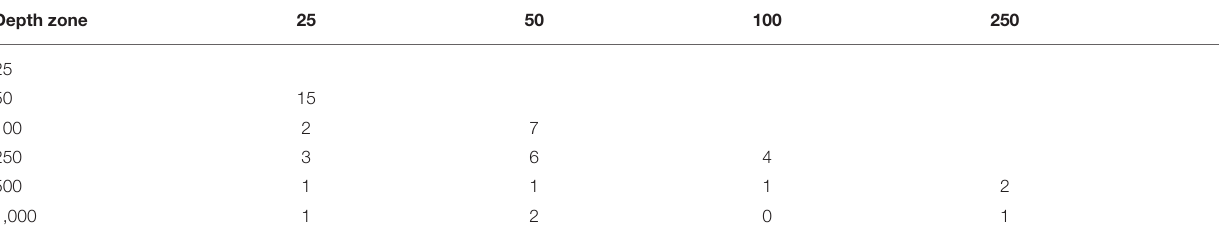
TABLE 3 | Species common between the depth zones.